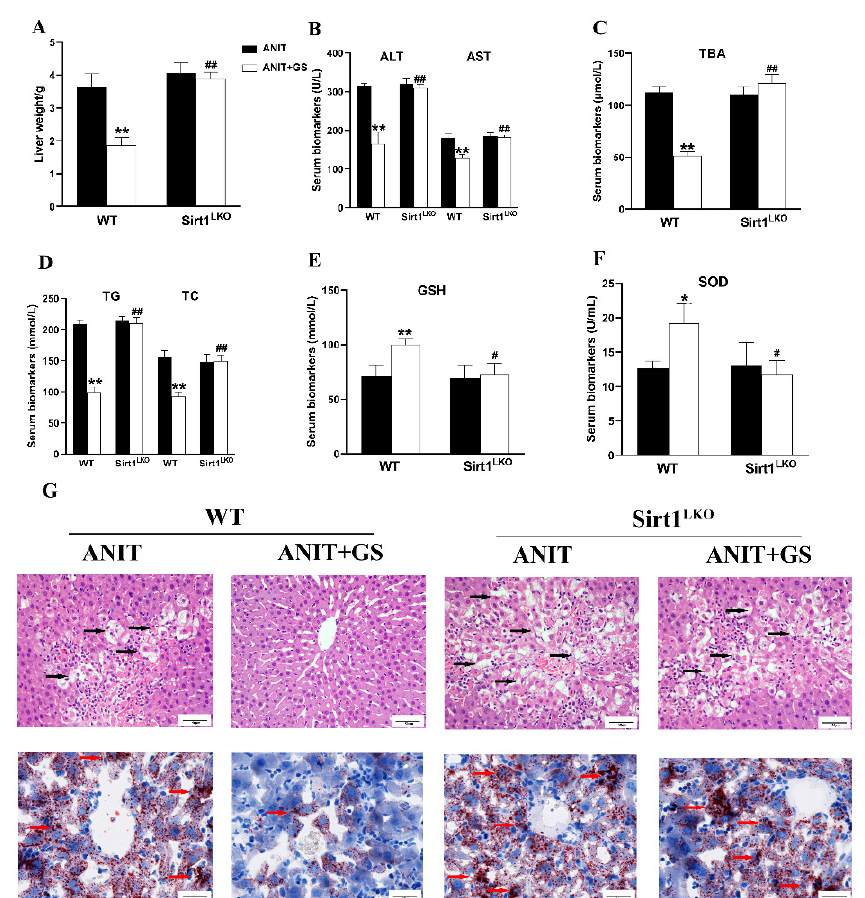
Figure 9. The therapeutic effect of GS was absent in SIRT1 LKO mice. ( A ) Liver weight changes (WT compared with SIRT1 LKO . ( B – F ) The biochemical indexes of ALT, AST, TBA, TG, TC, GSH, and SOD in the serum of mice. ( G ) Histopathology in hematoxylin and eosin-stained liver sections (scale bar, 50 µ m). Black arrows, histological damage. Morphology of frozen liver sections as tested by Oil Red O staining (scale bar, 20 µ m). Red arrows, lipid droplets. Significantly different from ANIT (WT), * p < 0.05 or ** p < 0.01, or ANIT+GS (WT), # p < 0.05 or ## p < 0.01.